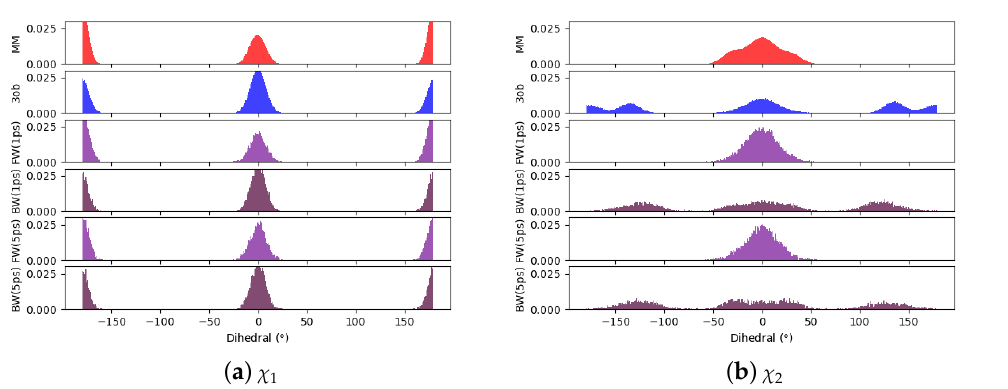
Figure 11. Dihedral populations for 8 ’s dihedral degrees of freedom (see Figure 2 for dihedral